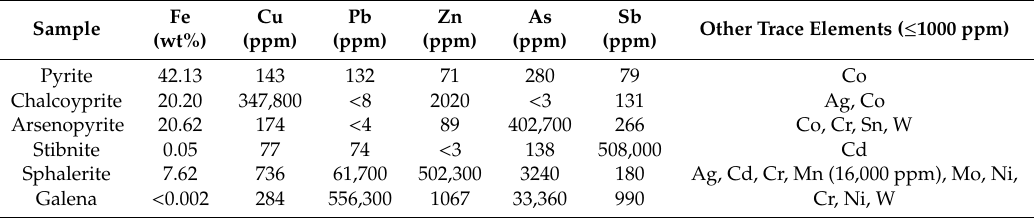
Table 3. Sulphide minerals geochemistry of significant metals and metalloids determined by pXRF.